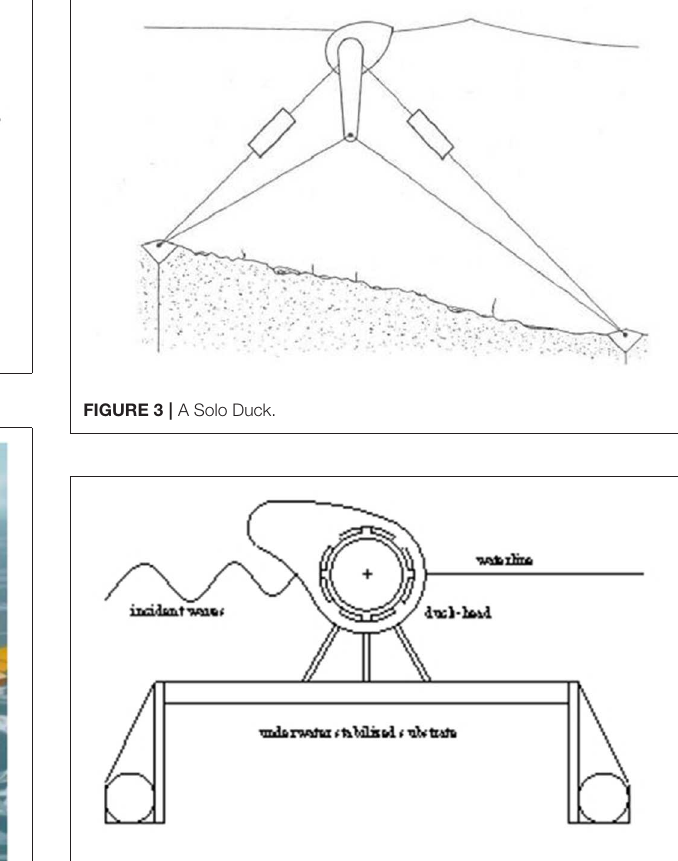
FIGURE 4 | The modified Duck device in working